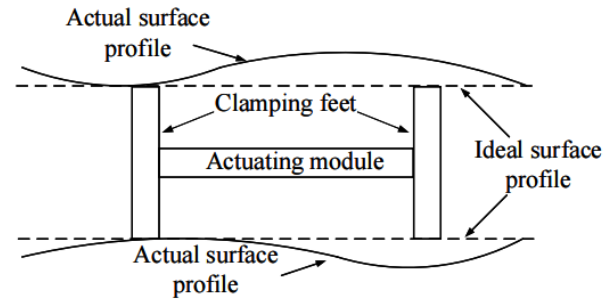
Figure 1. Influence of surface morphology of guide rail on motor clamping.